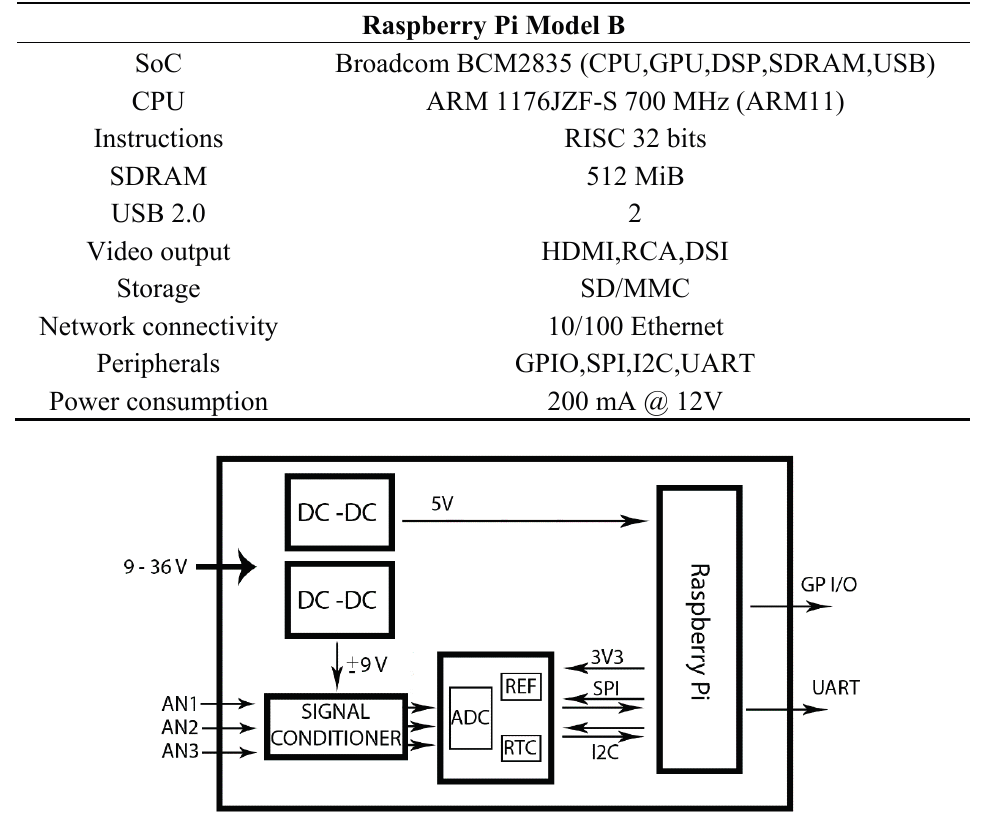
Table 5. Main Features of Raspberry Pi.